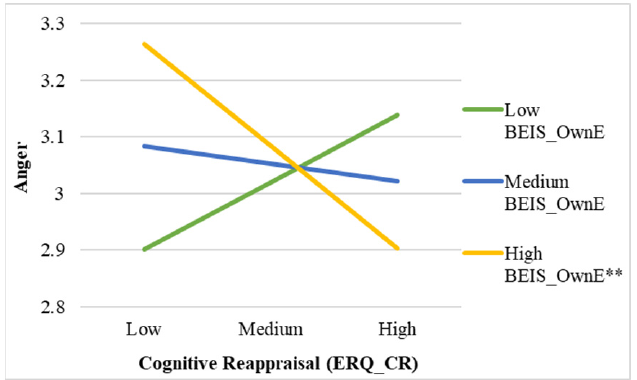
Figure A1. Plot of the relationship between Cognitive Reappraisal and Anger at low ( − 1 SD), medium (mean), and high (+1 SD) Appraisal of Own Emotion score; ** = p < 0.01.